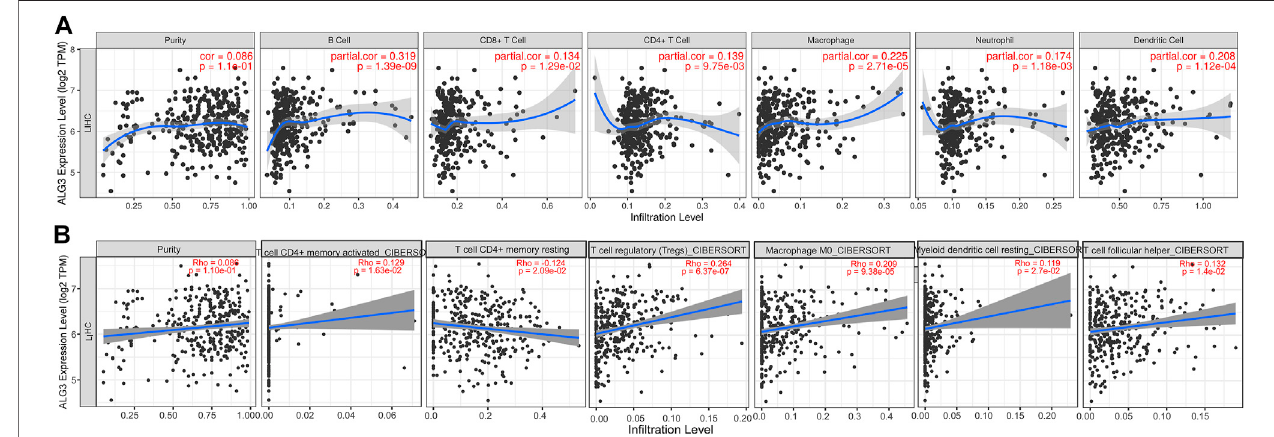
FIGURE 6 | Correlations of ALG3 expression with TILs in HCC. Correlations between the ALG3 expression and TILs were veri fi ed with TIMER web server (A) and CIBERSORT (B) .